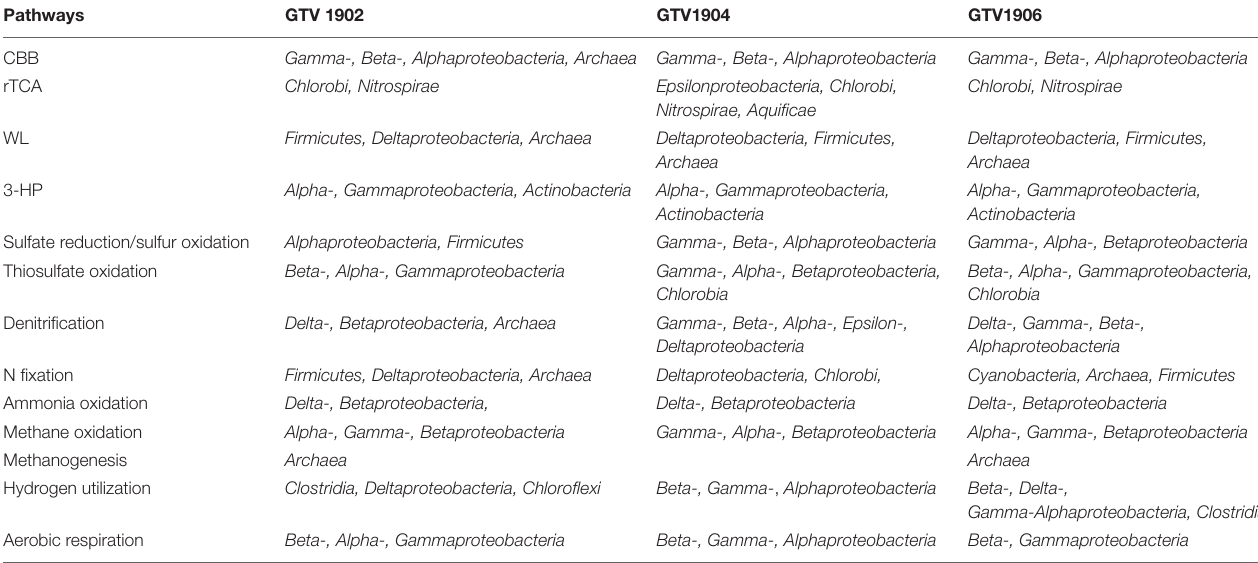
TABLE 2 | Assignment of metabolic roles to major taxonomic groups based on detection of key genes-coding proteins in the